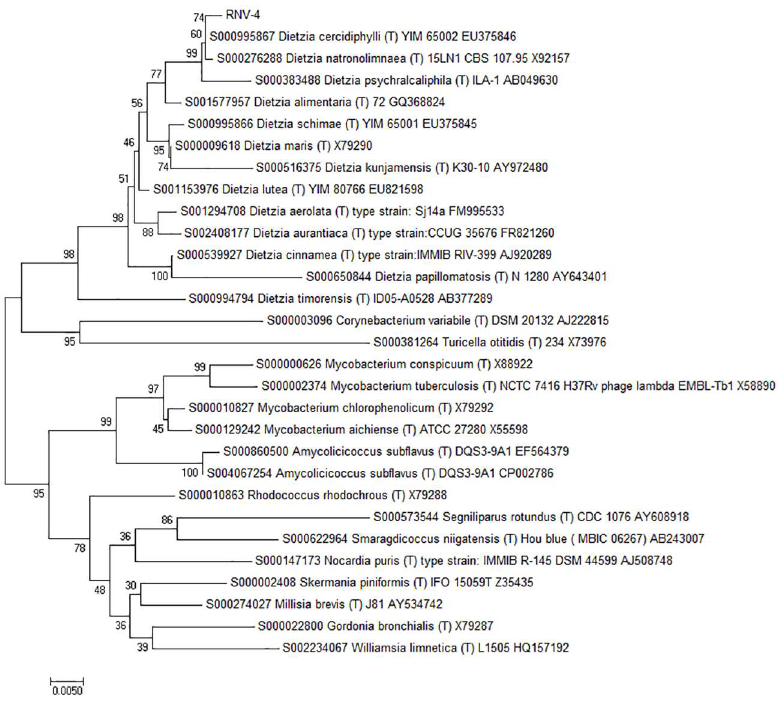
Fig 2. Phylogenetic tree of RNV-4 strain and closely related species based on 16S rRNA. The tree was constructed using the neighbor-joiningmethod. The numbers at nodesindicate the percentages of occurrence of the branching order in 500 bootstrappedtrees for values greater than 50%. Scale bar = 0.5% divergence.